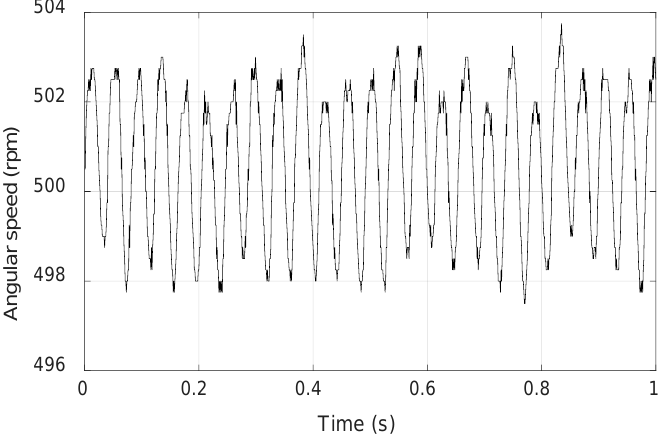
Figure 19. Angular speed response of the motor under the reference of 500 rpm.